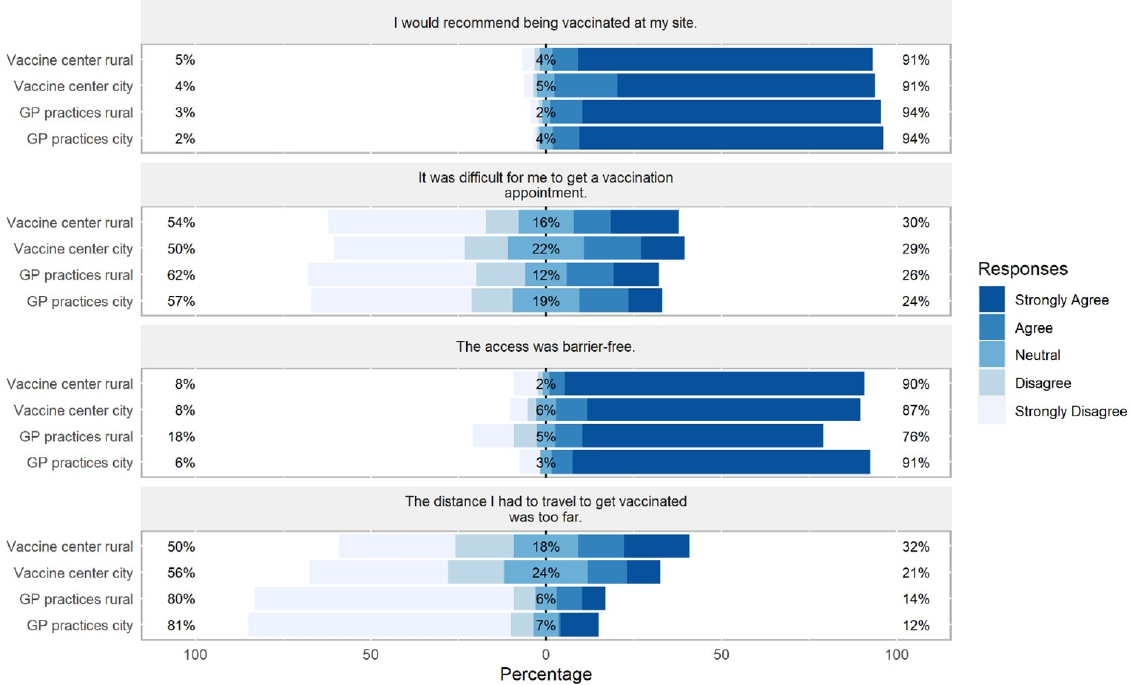
Figure 2. Differences between sites in participants’ responses on preference and access to vaccines. Percentages on the left and right side of the graph represent a summary of Strongly Agree and Agree on the right and Disagree and Strongly Disagree on the left